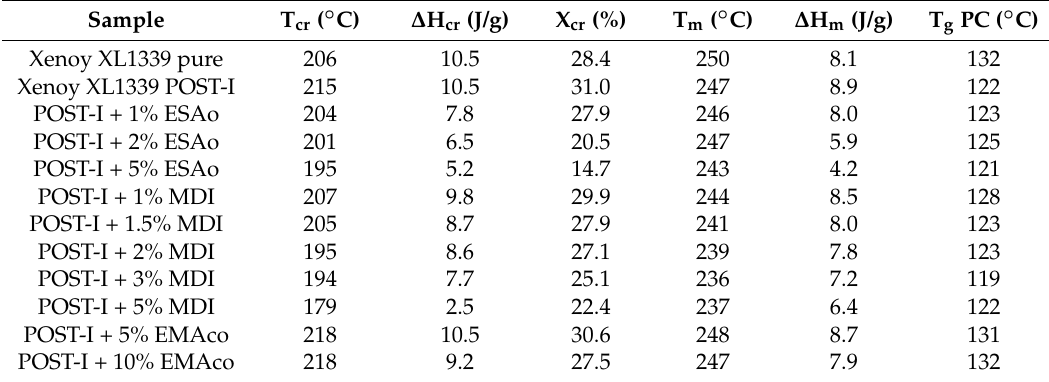
Figure 7. Second heating cycle differential scanning calorimetry (DSC) curves of: ( a ) pure and post-industrial (POST-I) blends without compatibilizers; ( b ) blends with different content of ESAo (1–5 wt %); ( c ) blends with different content of pure MDI (1–5 wt %); ( d ) blends with different content of EMAco (5–10 wt %). Table 2. Thermal characteristic of blends: T cr = crystallization temperature of polyethylene terephthalate (PET); ∆ H cr = total heat of crystallization of PET; X cr = degree of crystallinity of PET; T m = melting temperature of PET; ∆ H m = total heat of melting of PET; T g PC = polycarbonate glass transition temperature.